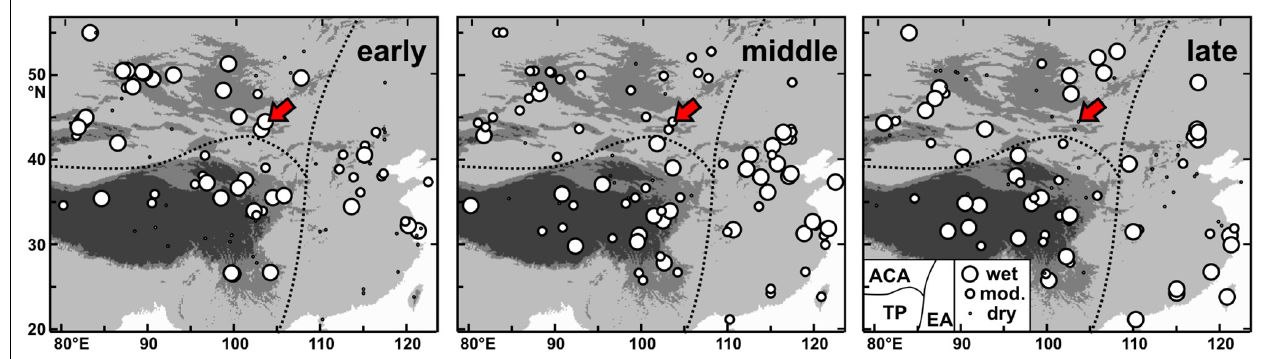
FIGURE 5 | Comparison of early, middle, and late Holocene moisture inferences (dry, moderate, or wet) for 101 records from arid Central Asia (ACA), the Tibetan Plateau (TP) and East Asia (EA). The majority (89) are pollen records examined by Herzschuh et al. (2019). In addition, 12 records from Bayan Tohomin Nuur (Felauer et al., 2012), Orog Nuur (Yu et al., 2019), Uigi Nuur (Wang et al., 2011), Hoton Nur (Rudaya and Li, 2013), the Nur Sphagnum Bog (Fukumoto et al., 2012), Wulungu Lake (Liu et al., 2008), the Yili Section (Li et al., 2011), the peat record BBP-13 (Xu et al., 2019), Kesang Cave (Cai et al., 2017), Zhuyeze Lake (Mischke et al., 2016), Lake Dali (Goldsmith et al., 2017), and this study (red arrow) are